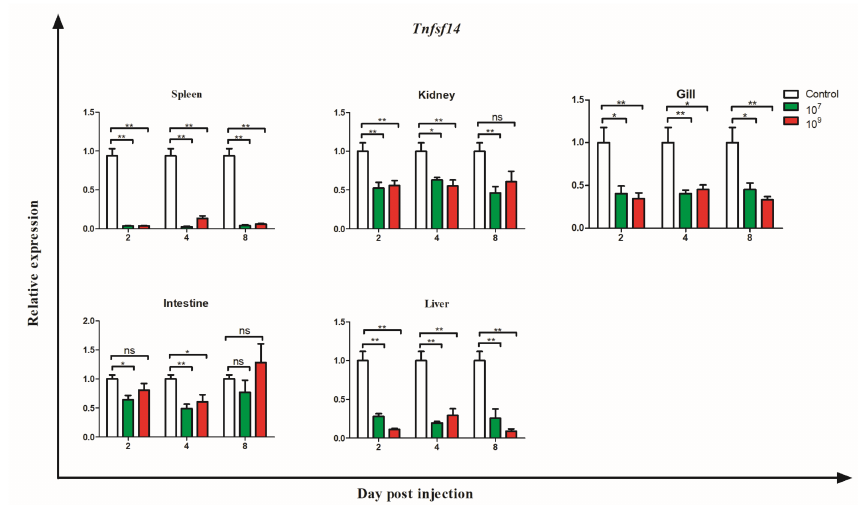
Figure 7. Expression analysis of tnfsf14 after infection with K. peneumoniae . Fish were i.p. injected with 0.1 mL 1 × 10 7 or 1 × 10 9 CFU/mL K. pneumoniae suspension. Ef-1 α was used as an internal reference gene for normalization of gene expression. The expression levels of genes were compared with that of the control group (defined as 1). Bars represent mean + SEM ( n = 5). Significant differences are indicated by * ( p < 0.05) and ** ( p < 0.01). ns = no significant difference.